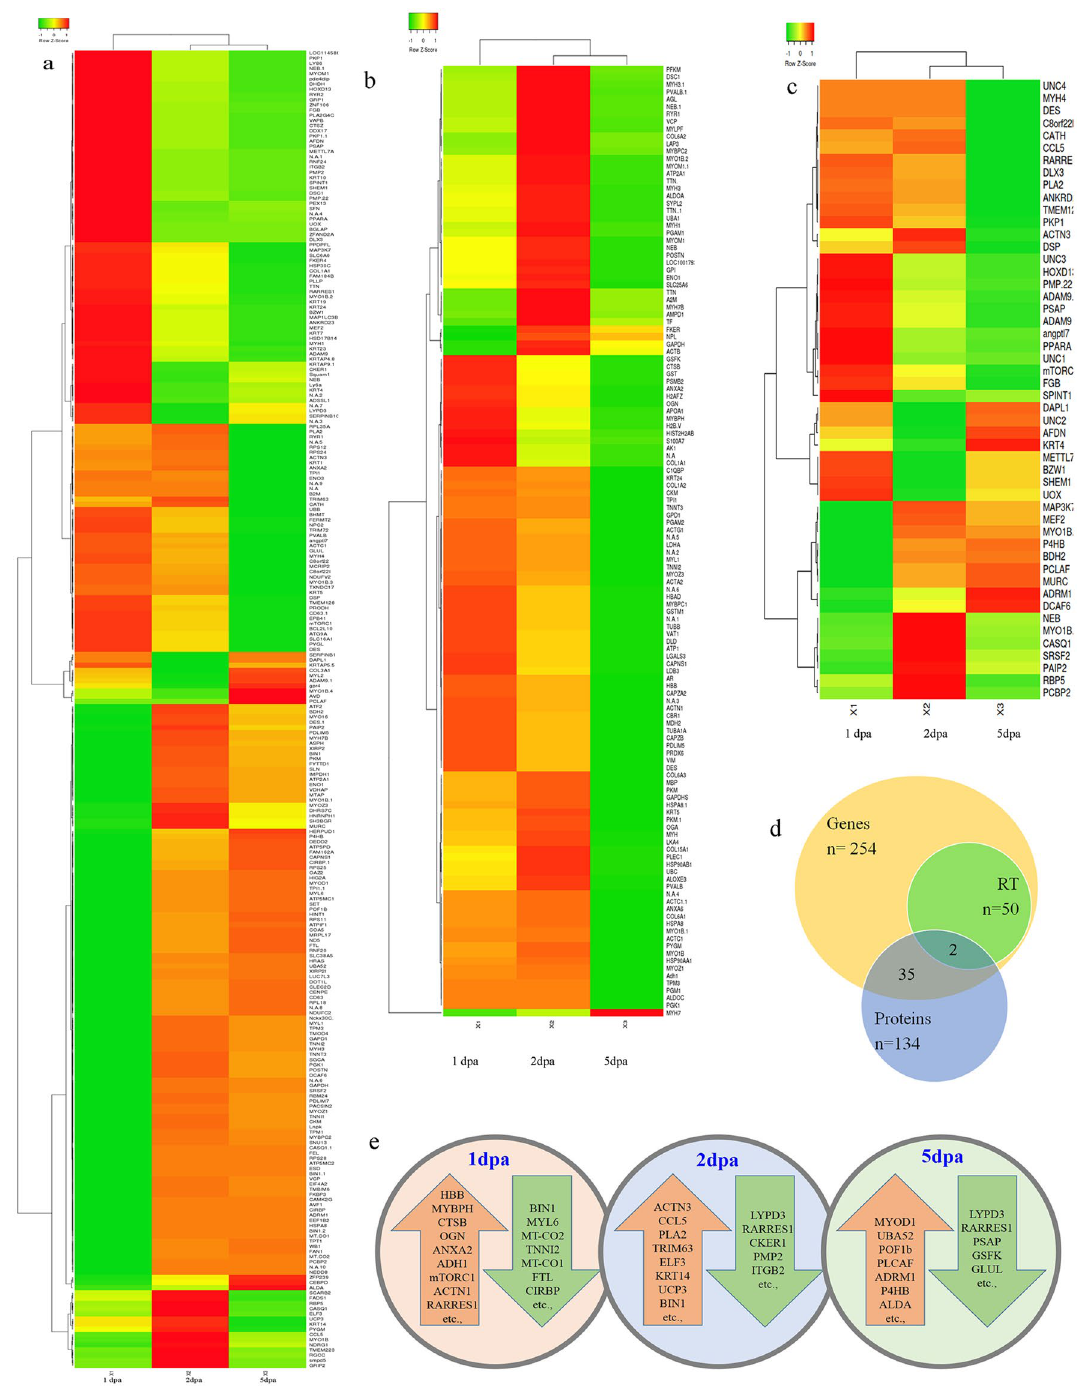
Figure 1. ( a ) Heap map expression of Hemidactylus frenatus transcript during tail tissue regeneration. ( b ) Heat map expression of differentially expressed proteins which are associated with tail regeneration; ( c ) Heat map expression of various genes differentially regulated during regeneration based on RTPCR analysis. ( d ) Venn diagram for number genes identified from Transcriptomics, proteomics and Real time PCR based gene expression analysis; e. Batches of genes/proteins which are differentially expressed at 1, 2 and 5-dpa. Genes/ proteins which are in the red/organge arrow indicates the upregulation and in the green arrow indicates the